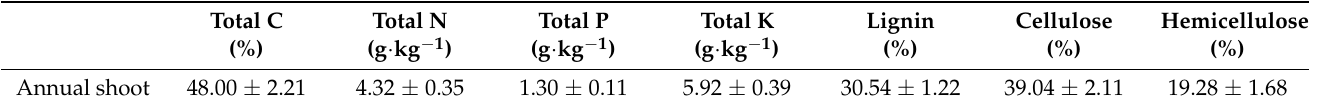
Table 1. Properties of the 3 years of experimental material (mean ±